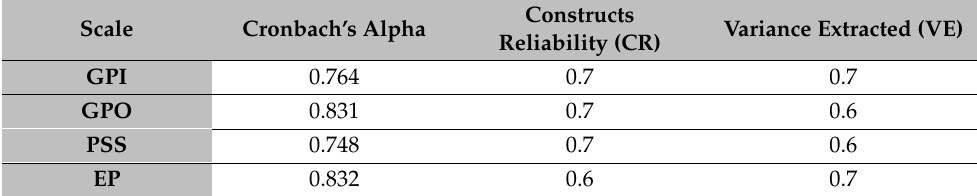
Table 4. Cronbach ‘s alpha, CR, and